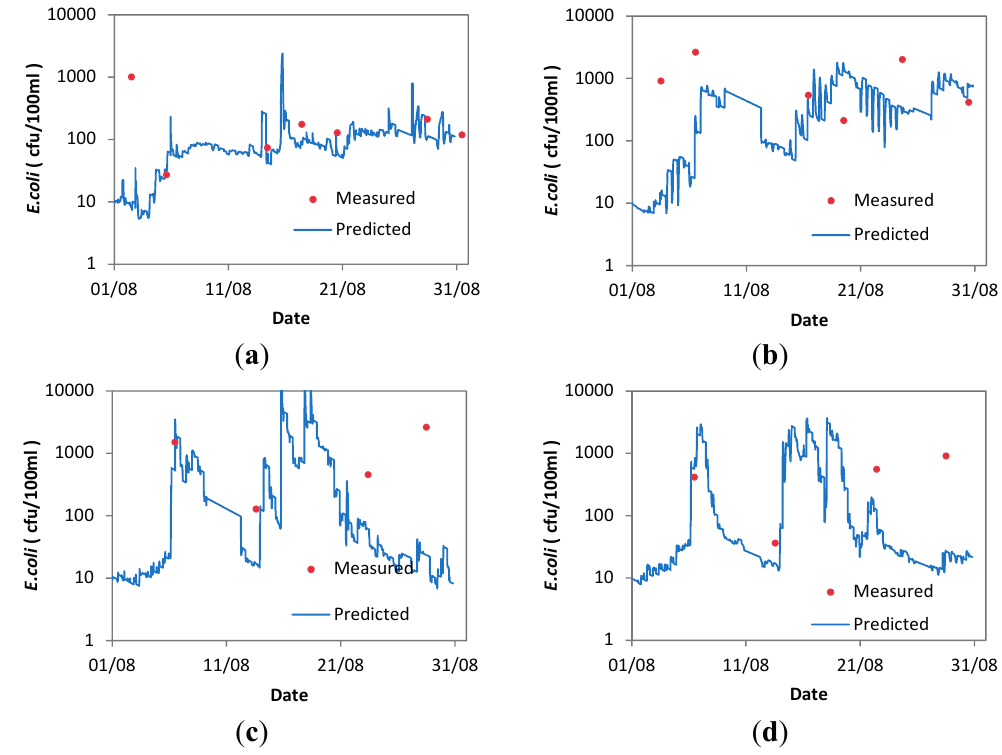
Figure 5. Escherichia coli concentrations (colony forming units) verification at 4 bathing water compliance sites in August 2012 (see Figure 1 for locations), at sites: ( a ) Site 41300 (see Figure 1); ( b ) Site 41800; ( c ) Site 42100; ( d ) Site